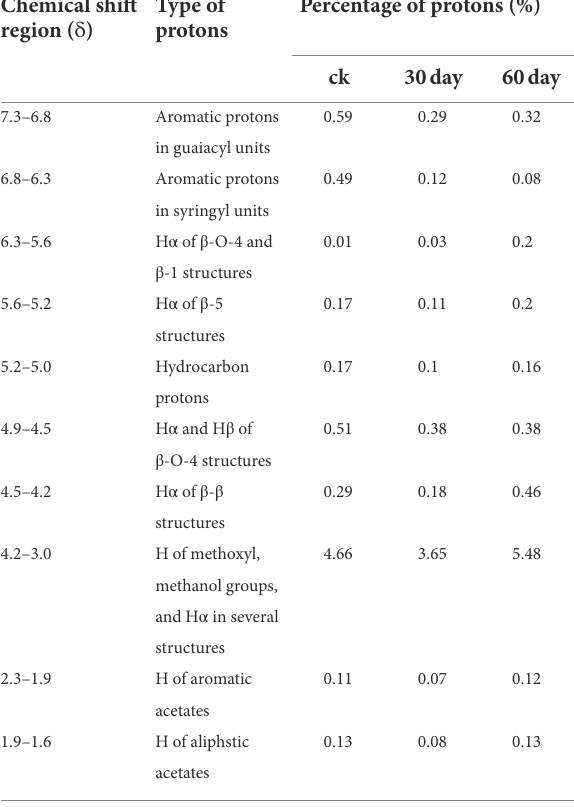
TABLE 4 Low-molecular-weight compounds identified as tetramethylsilane derivatives in chloroform extracts of P. ostreatus degraded cotton stalk samples at various growth